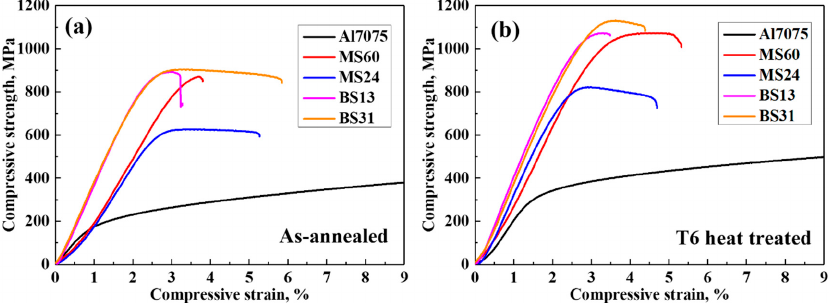
Figure 2. Compressive strength of the composites in ( a ) as-annealed and ( b ) T6 heat-treated states.